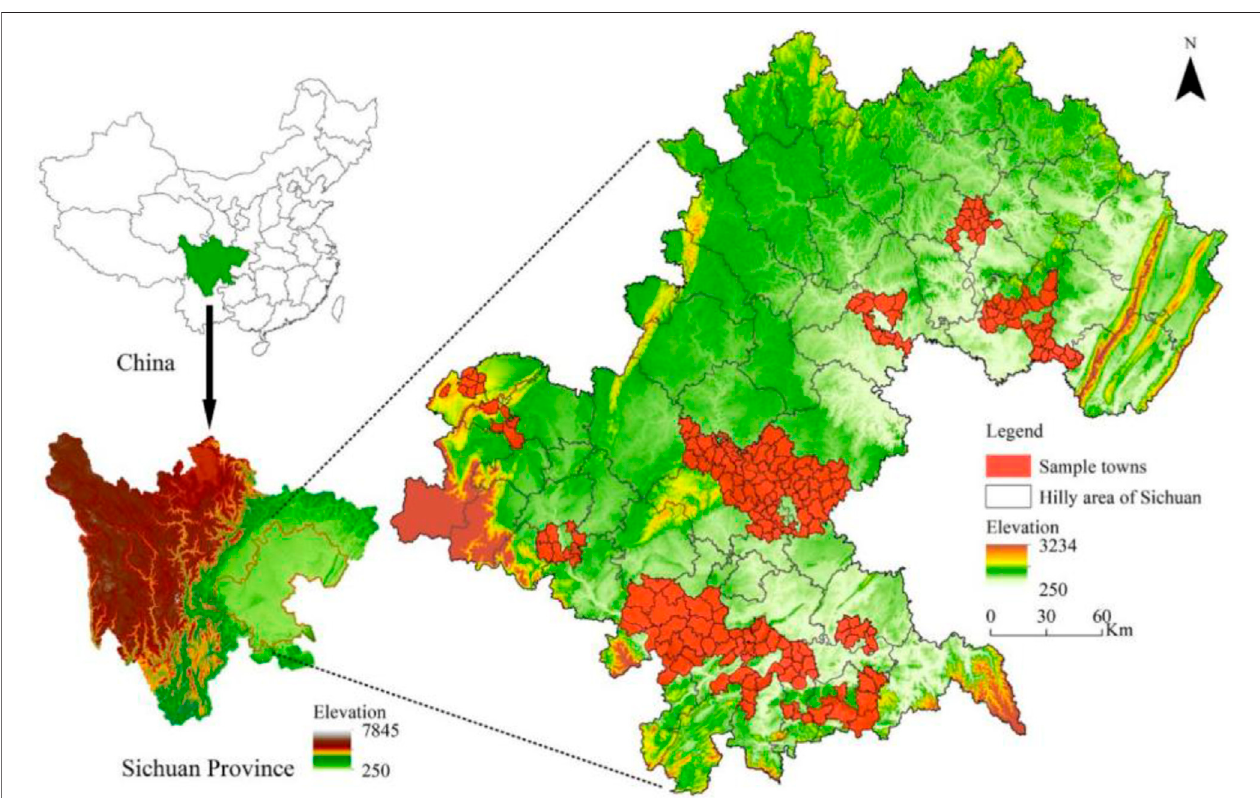
FIGURE 4 | The study area and sample distribution in typical hilly areas, SW